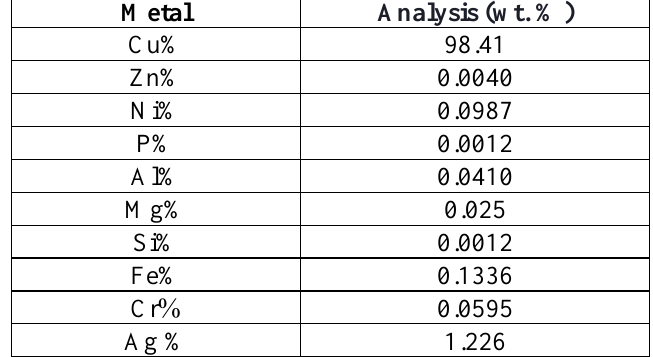
Table 1: Analytical chemical compositions of the copper